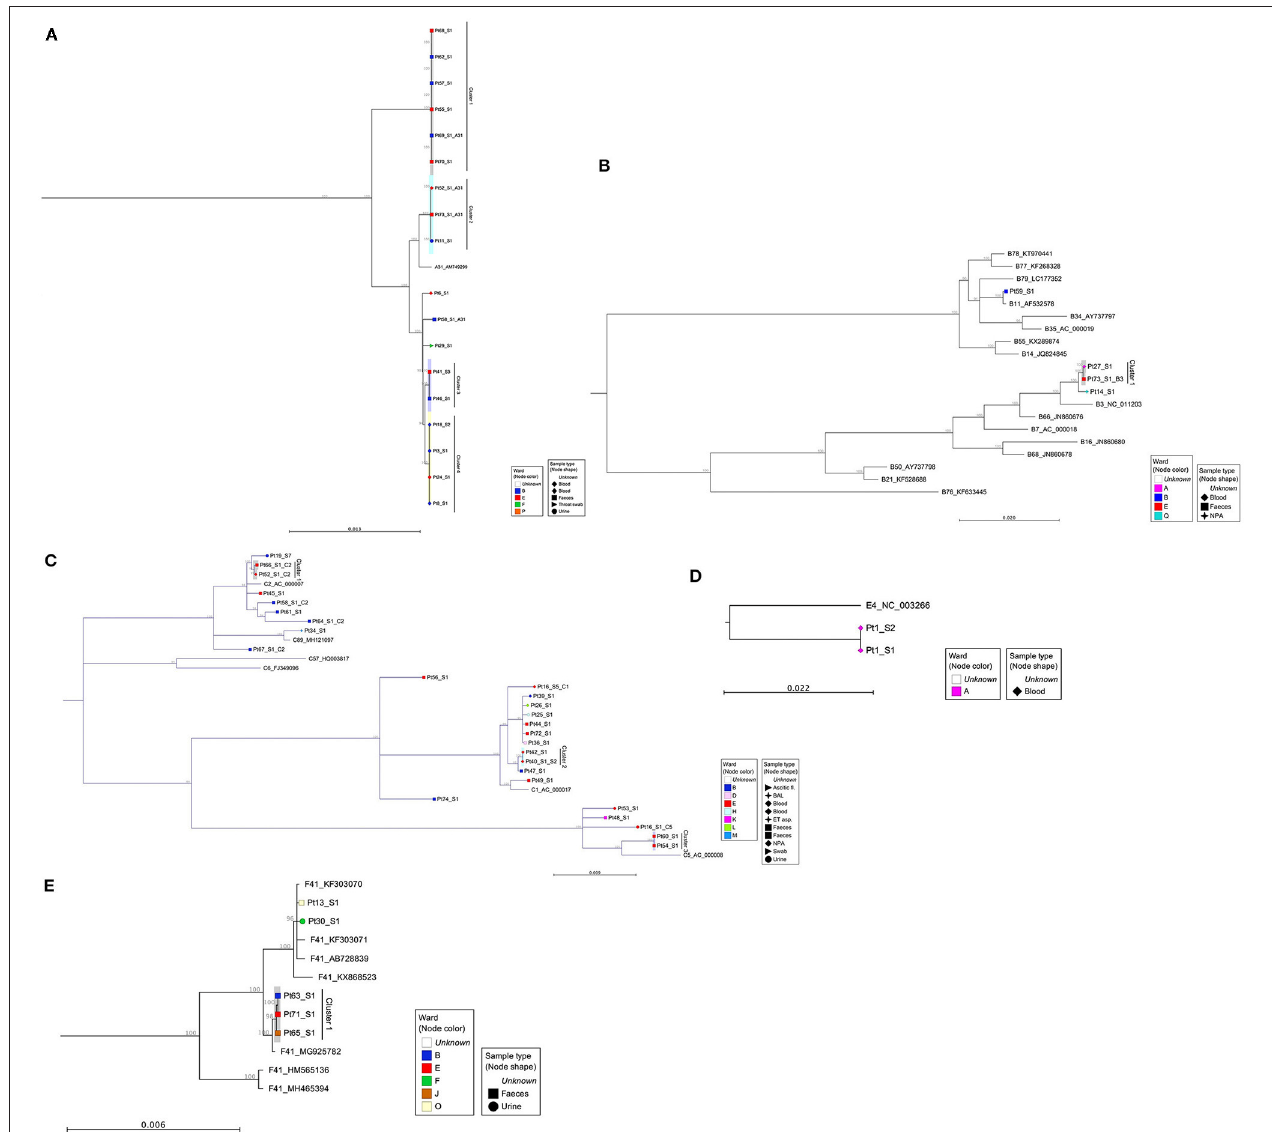
FIGURE 2 | Maximum likelihood phylogenies of adenovirus full genome sequences, organized by species: (A) species A viruses, (B) species B viruses, (C) species C viruses, (D) species E, and (E) species F viruses. Sequences were aligned and maximum likelihood phylogenies generated using CLC Genomics Workbench (version 12.0.1), 500 bootstraps. Clinical samples are labeled according to their anonymized patient number (PtX) and specimen number (_SX). Additional samples from sequentially sampled patients have been collapsed. Inter-species reference sequences (A12, A18, and A61) were also removed from phylogeny A and from phylogeny E (F40) to aid visualization of patient samples. The shape of each node correlates with the sample type and color, the ward on which the sample was taken. Reference sequences are identified by their HAdV genotype and GenBank Accession. A bootstrap threshold of 80% is shown. Any clinical samples from at least two patients, with a bootstrap support > 90, were considered a cluster. The parsimony informative site for each phylogeny is as follows: (A) 2979/34444, (B) 7054/36263, (C) 3104/36332, (D) 1348/36046, and (E) 4455/34469. For phylogeny D, there are only three sequences, out of which two are identical. In this case, the sites reported are only the variable sites between the two groups. NPA, nasopharyngeal aspirate; BAL, bronchoalveolar lavage; ET aspirate, endotracheal